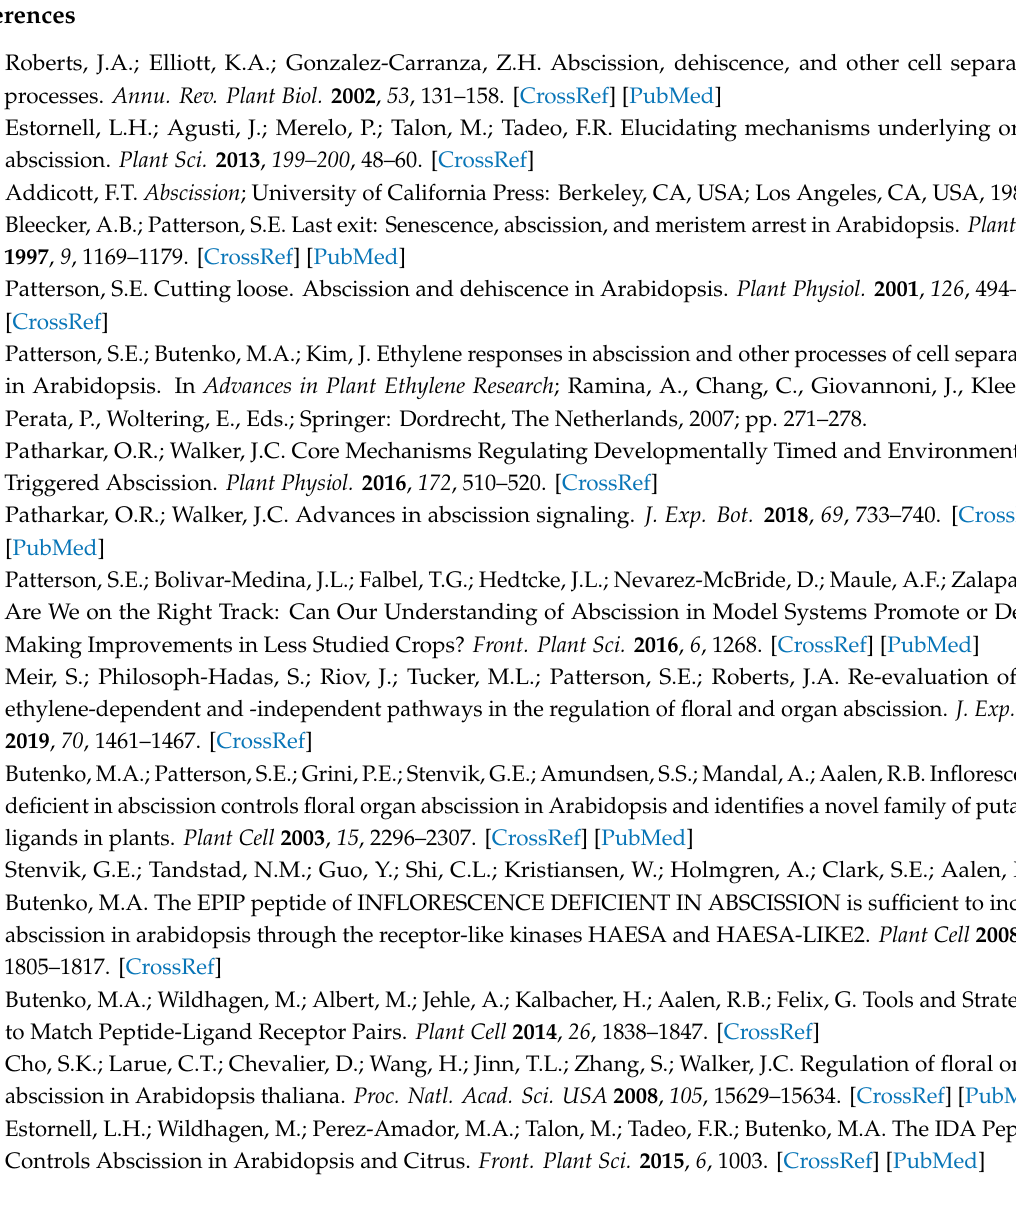
Figure S1: IDA peptide methodology, Figure S2: Phenotypes for AI